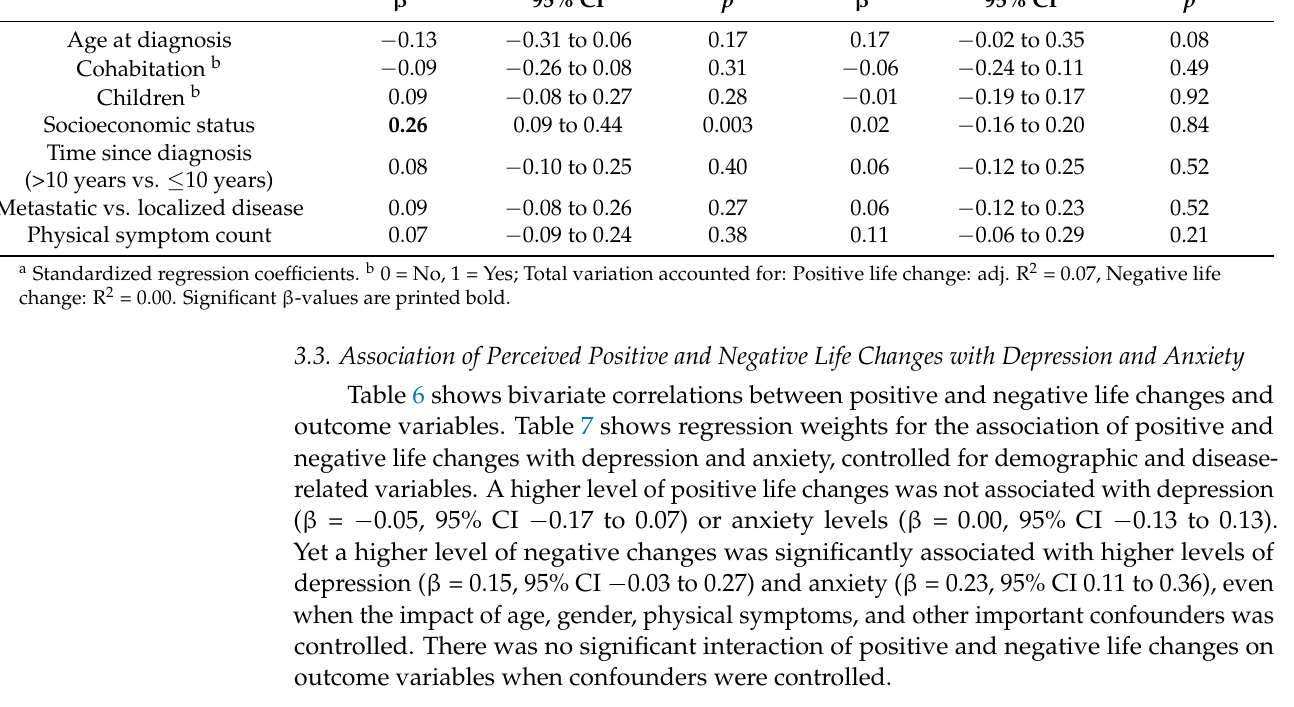
Table 5. Multiple linear regression model analyzing predictors of positive and negative life change scores ( N = 164). Positive Life Change Negative Life Change β a 95% CI p β a 95% CI p